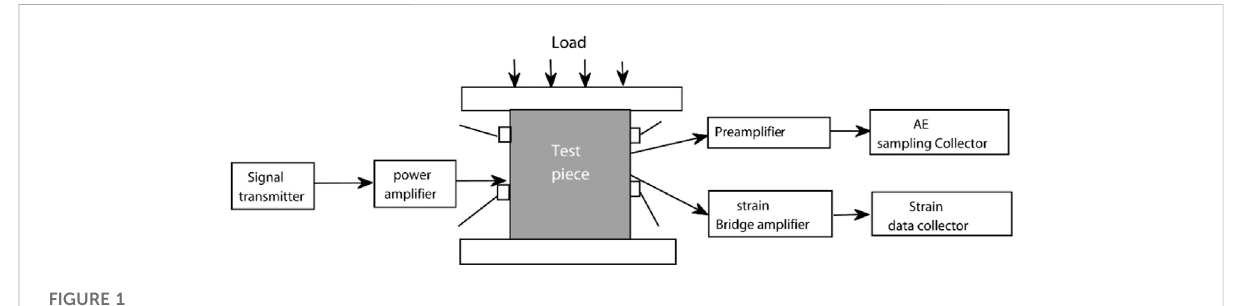
FIGURE 1 Schematic diagram of experimental